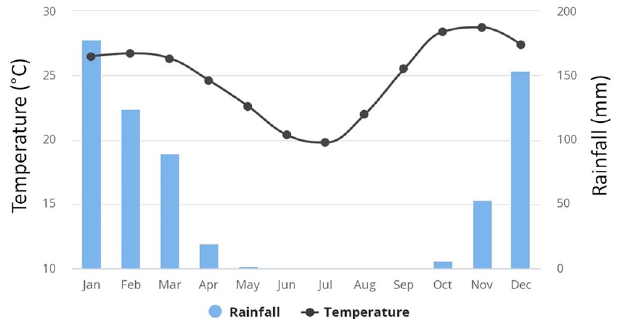
Figure 1. Average monthly temperature and rainfall at location 16°23 ′ S, 30° 58 E in Mbire district of Zimbabwe for 1991–2016. Source : World Bank Group Climate Change Knowledge Portal,